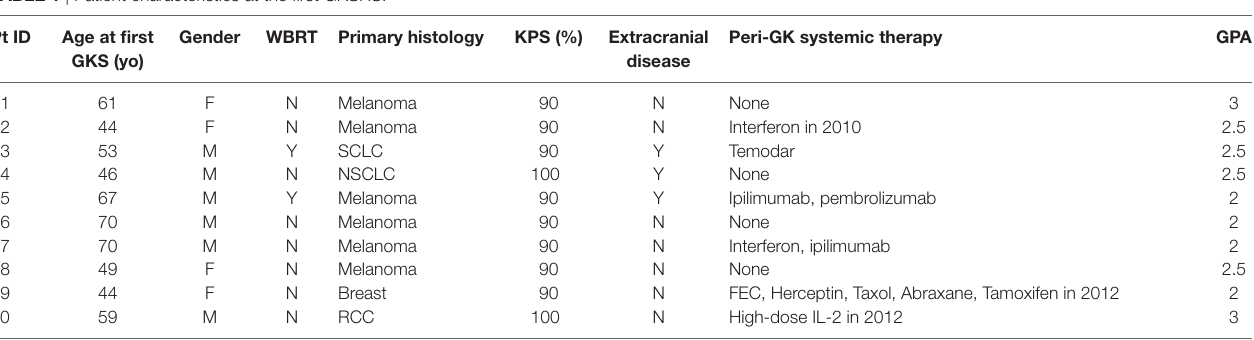
TaBle 1 | Patient characteristics at the first